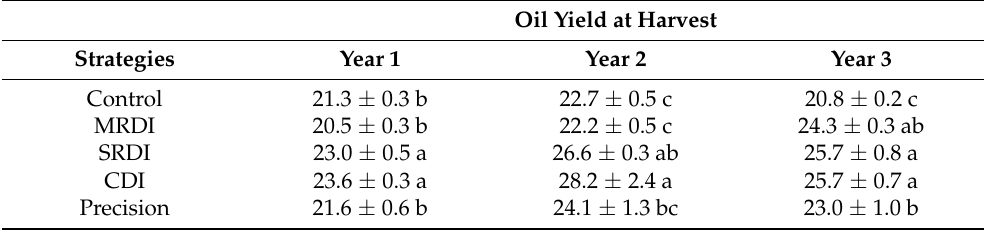
Table 9. Oil yield (%) measured by the Abencor ® method at harvest in the three irrigation campaigns. Values were mean ± standard deviation. Different letters showed significant differences ( p ≤ 0.05) among treatments for the same year according to Duncan’s test.